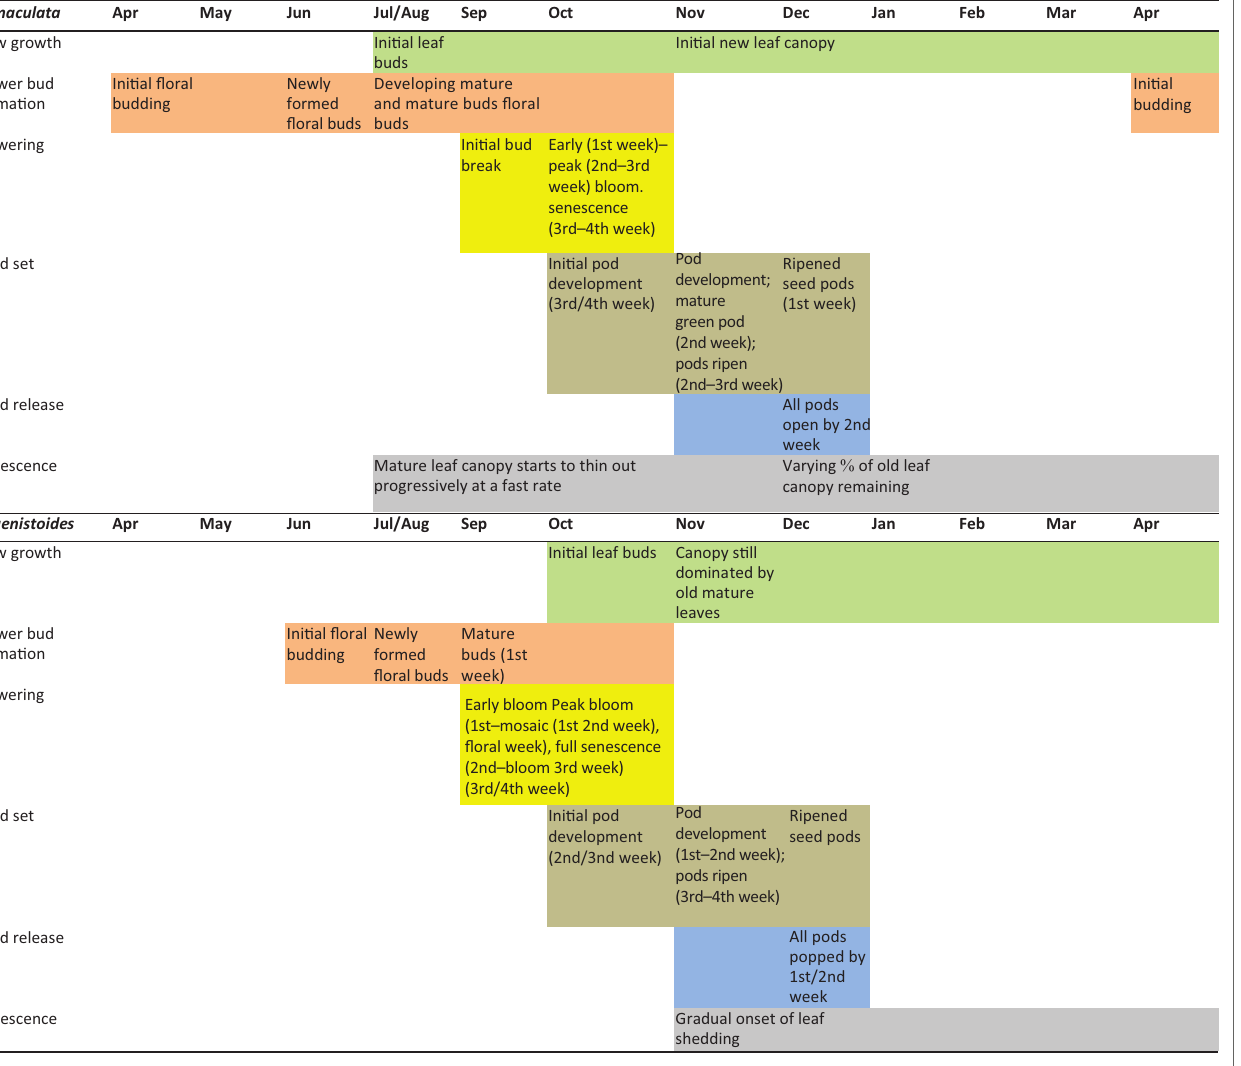
FIGURE 2: Phenology and life history phases for wild Cyclopia maculata (reseeder) and cultivated Cyclopia genistoides (resprouter) in the Overberg region, South Africa, from April 2014 to April 2015. Life history phases (left hand column) colour codes across the two